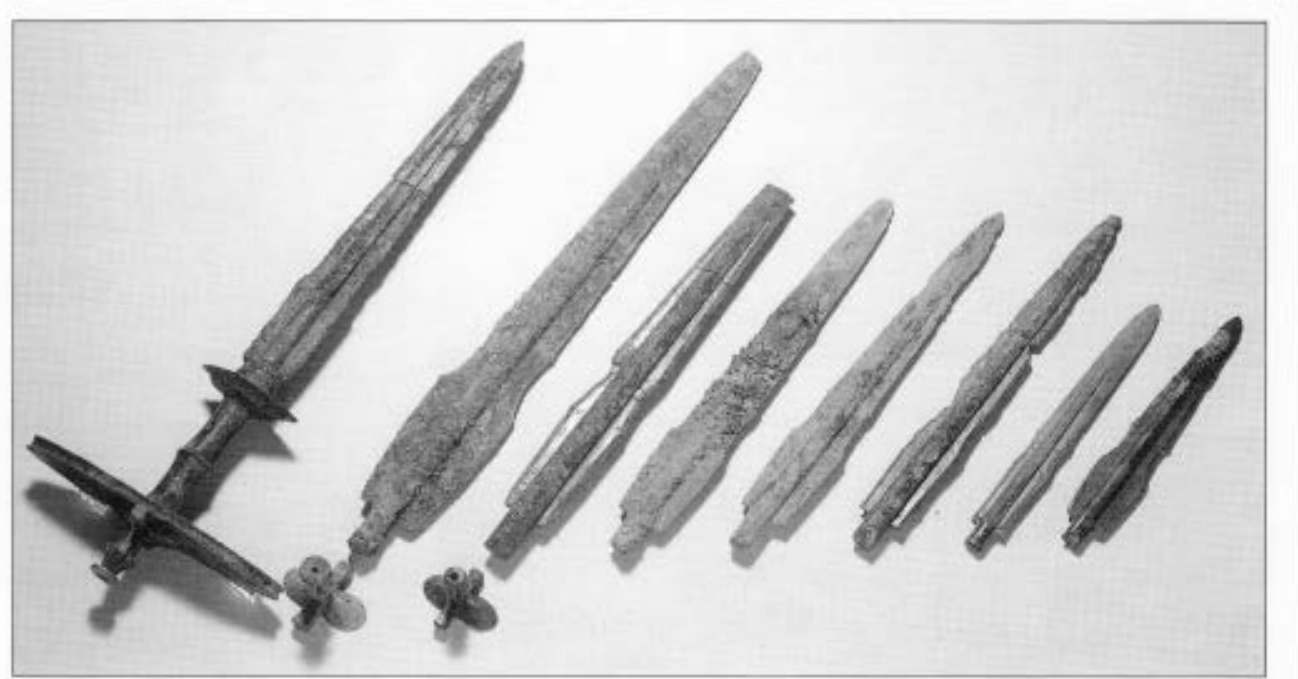
Figure 5 Bronze daggers from the cemetery at Yoshinogari. The longest dagger measures approximately 45 cm from end to end.